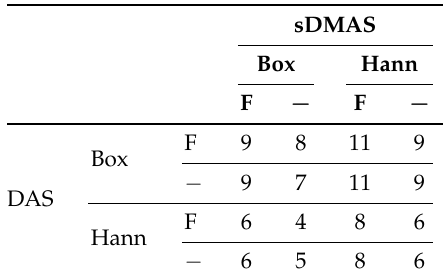
Table 1. Increase in CNR using sDMAS in different variants (columns) compared to DAS in different variants (rows) in db for µ a = 8.5cm − 1 . Box and Hann denotes if box car or Hanning apodization is compared. F denotes the use of a bandpass filter. For instance, the sDMAS algorithm with boxcar apodization and no bandpass filter (sDMAS, Box, -) on average yielded an improvement of 8db in CNR over the DAS algorithm with boxcar apodization and using a bandpass filter (DAS, Box, F). CNRs are averaged over n = 100 slices and three signals in depths of 8mm to 18mm. The increases in CNR over the three structures in different depths had standard deviations of 2db. sDMAS Box Hann F − F − Box DAS